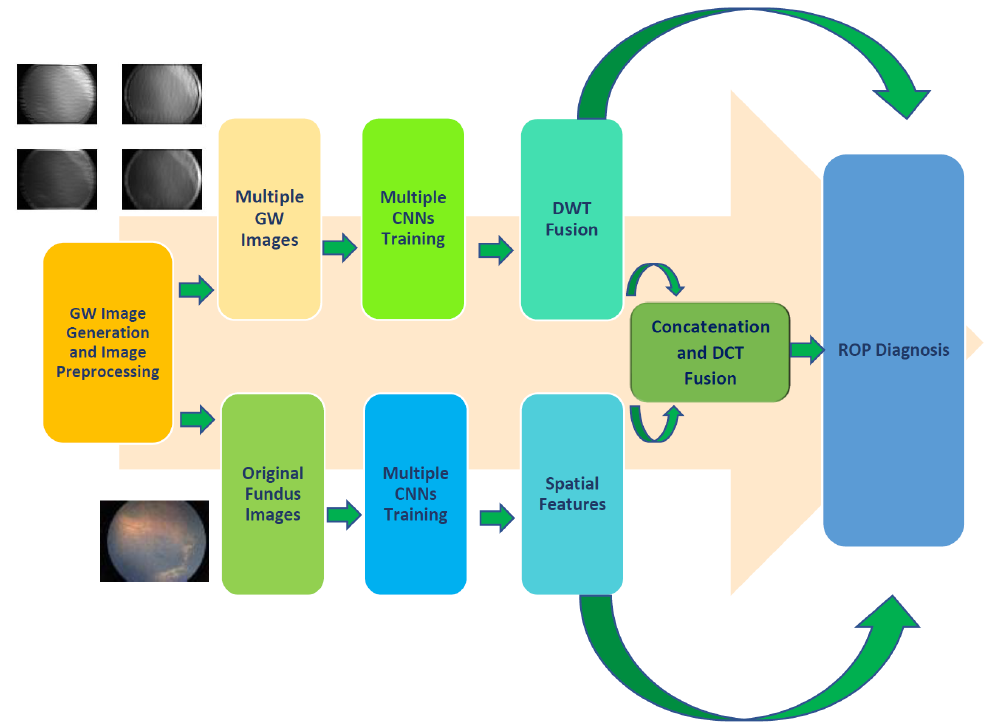
Figure 2. The stages of the proposed GabROP CAD